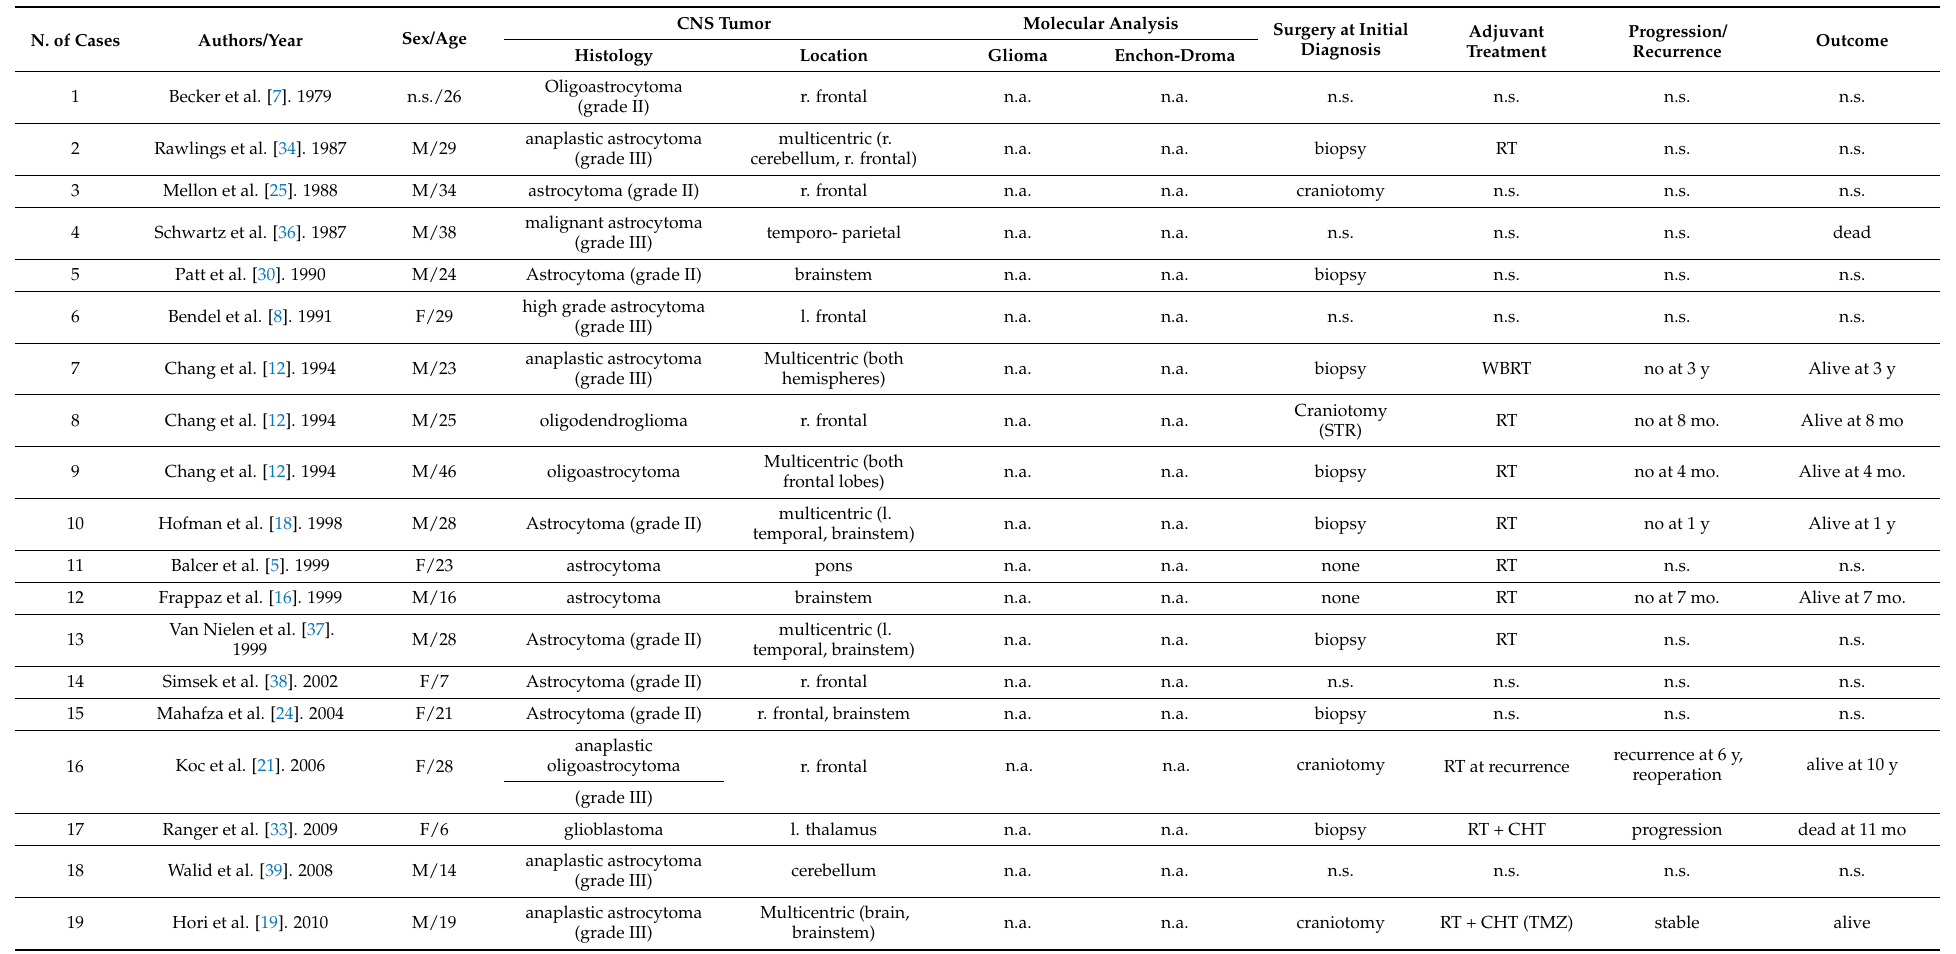
Table 1. Demographic and pathological